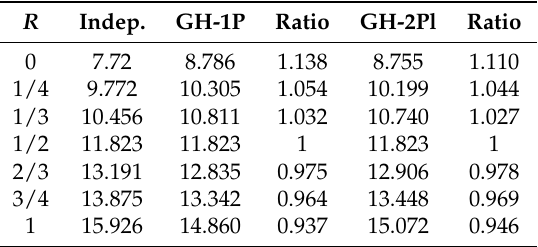
Table 11. Reversionary annuity price for the old generation under independence and using best-fit 1P, 2P copulas.